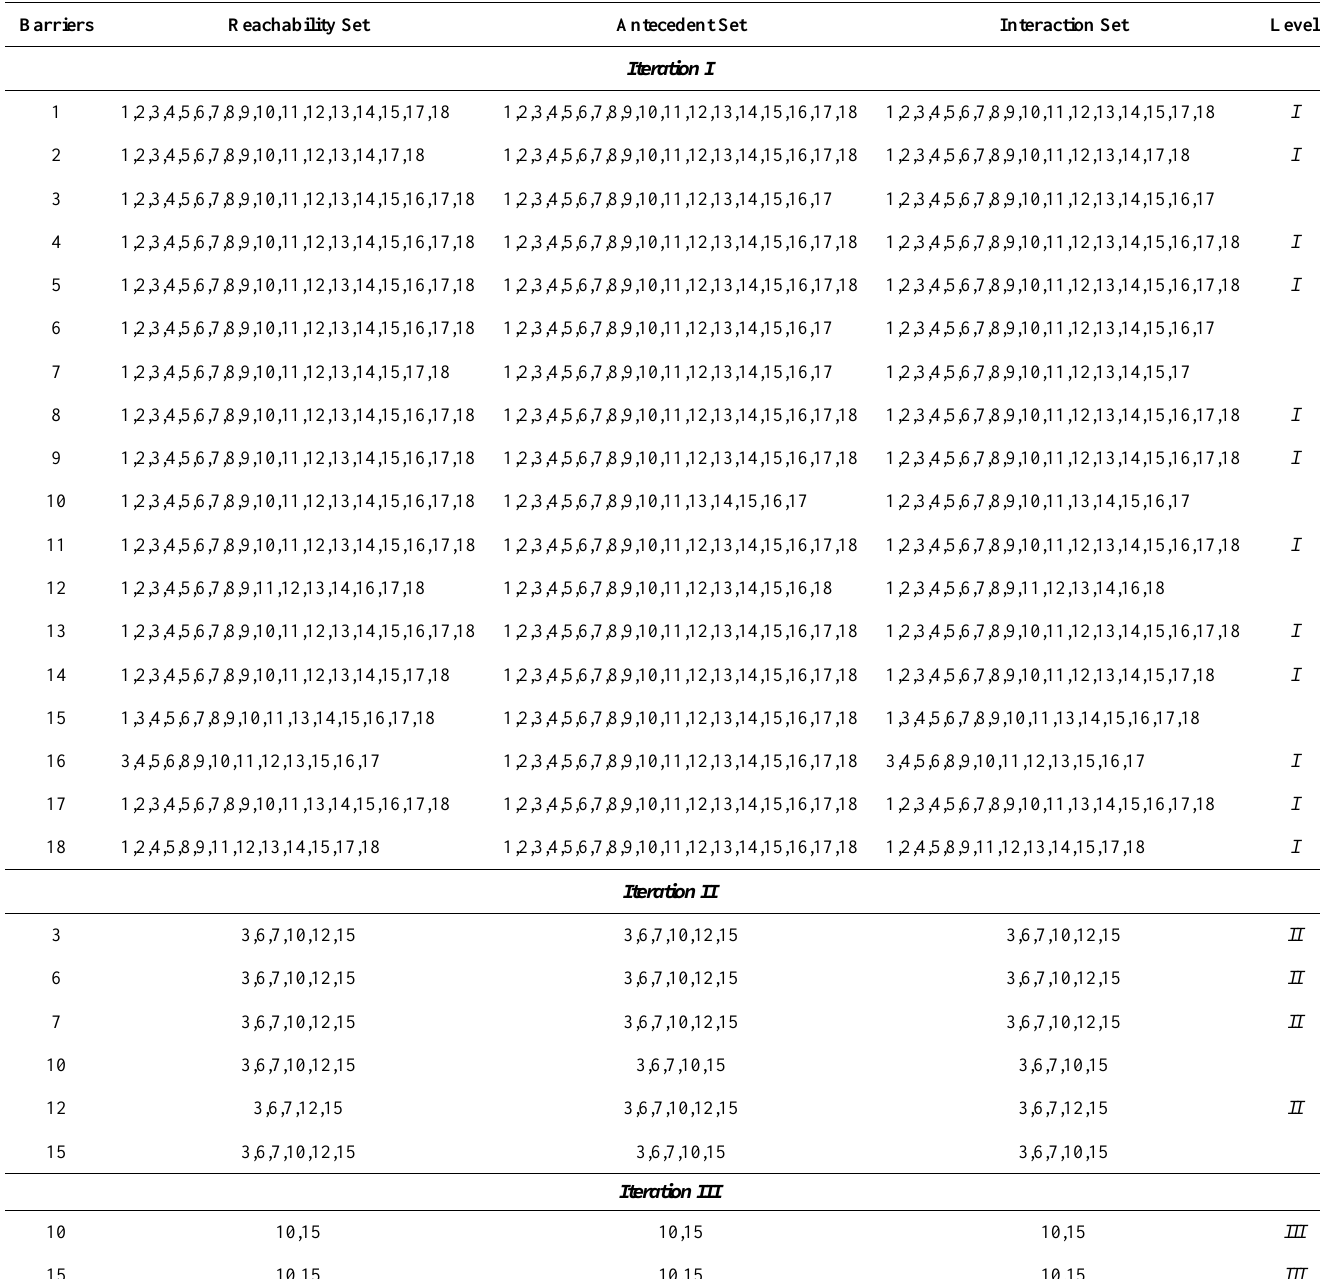
Table 7. Summary of